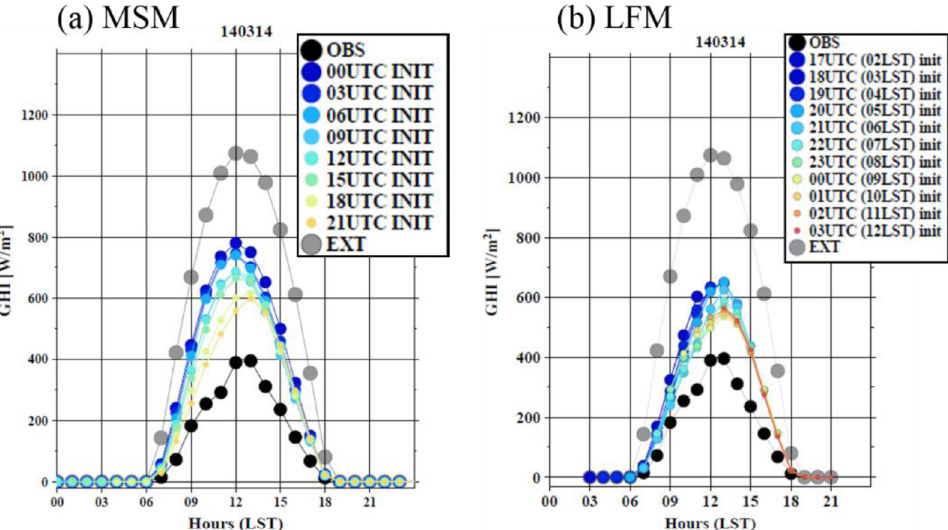
Fig. 3. Time series of hourly GHI values on March 14, 2014 for TEPCO area. (a) MSM and (b) LFM forecasts. Observations (black circles), extra solar irradiance (gray circles), forecasts with different initialization times (colors) are shown.